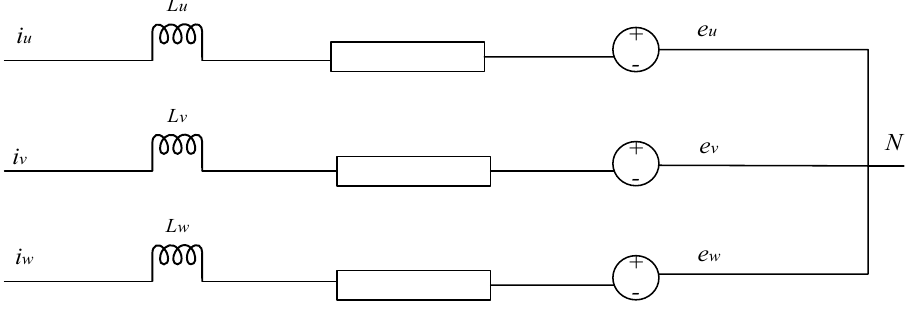
Fig. 1 Equivalent circuit of